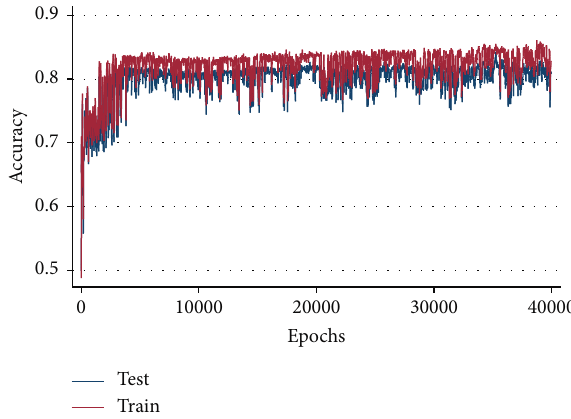
Figure 9: Prediction accuracy of the LSTM-CNN model without game theory